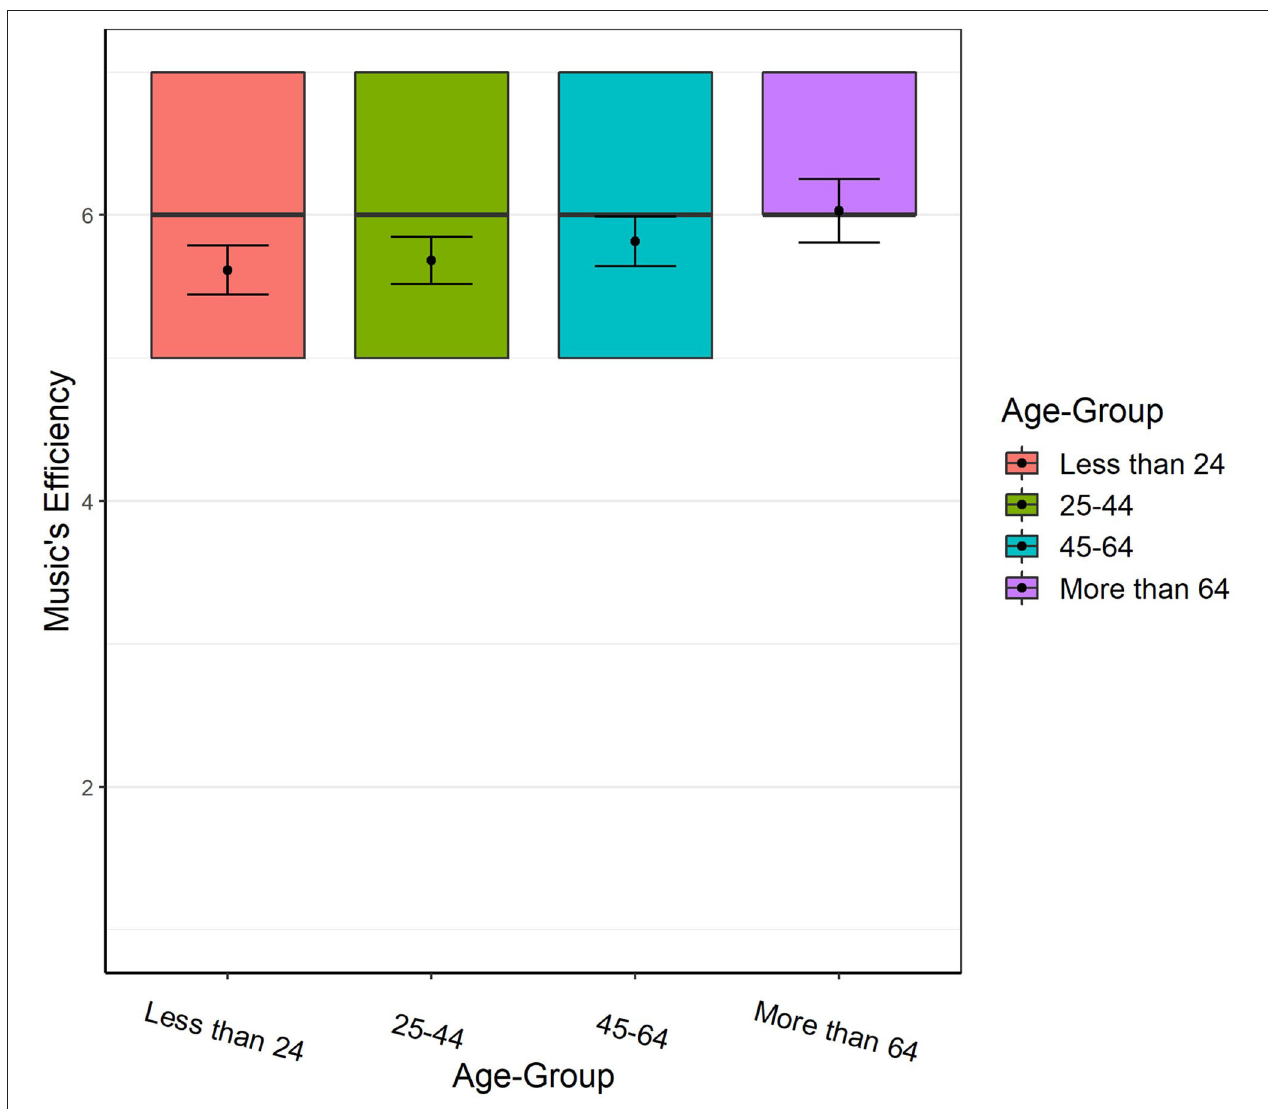
FIGURE 4 | Efficiency of music in obtaining Togetherness by age. Error bars represent 95% CI. Colored squares represent the 2nd and 3rd quartiles of responses. Black lines represent the median, and dots represent the